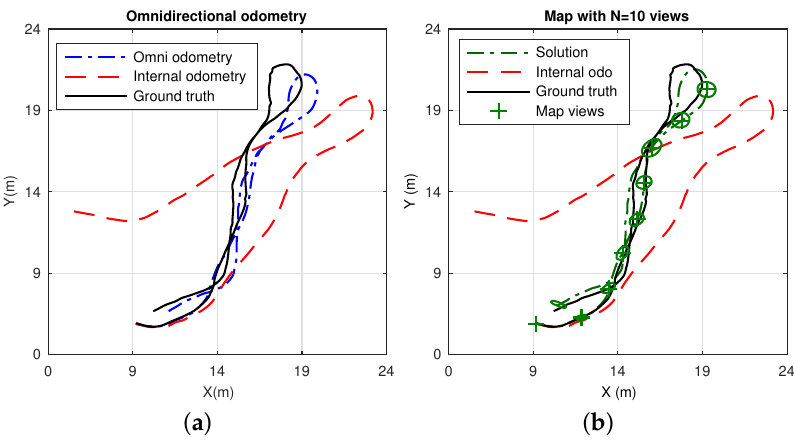
Figure 19. SLAM results in Dataset 2: ( a ) estimated omnidirectional visual odometry, drawn in dash-dotted line, ground truth in continuous line and internal odometry in dashed line; ( b ) estimated SLAM solution, in dash-dotted line, when the prior input is the omnidirectional visual odometry shown in ( a ). Again, the ground truth and internal odometry are also presented. The final map is constituted by N = 10 views, with their associated uncertainty ellipses.